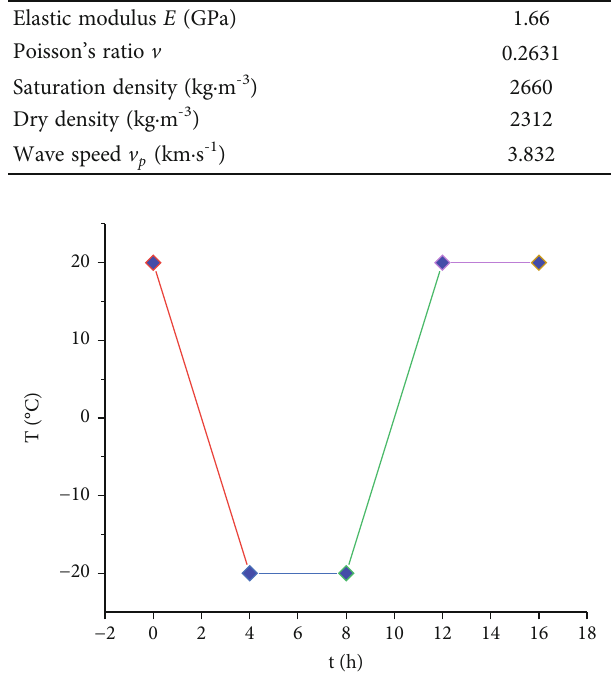
Figure 2: Freeze-thaw time-temperature